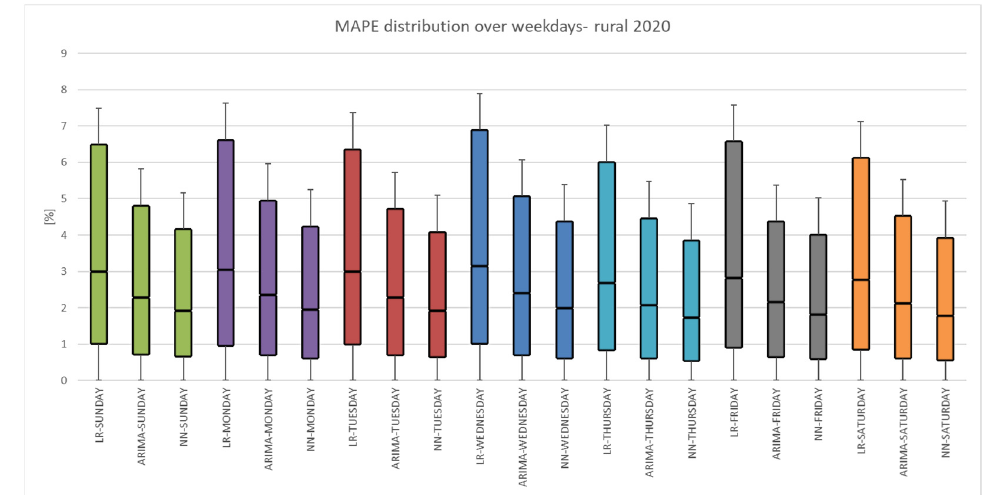
Figure 10. Overall forecasting results for rural consumers in 2020.